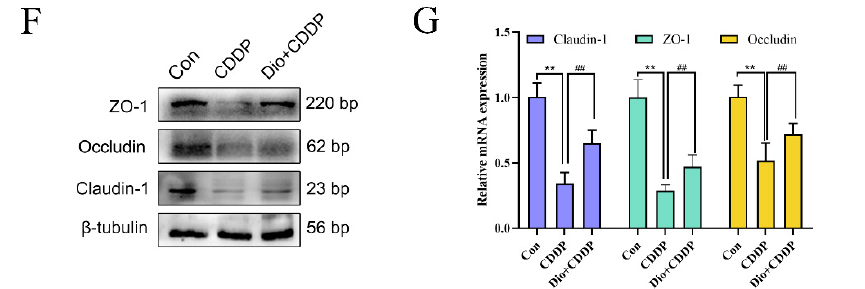
Figure 4. Dio protects the intestinal physical barrier by inhibiting CDDP-induced loss of E-cadherin and TJs proteins expression. ( A ) Bacterial culture results of MLNS. ( B )Bacterial translocation was analyzed by counting the number of colonies on the plate. ( C – E ) Changes in the relative protein expression levels of ZO-1, Occludin and Claudin-1 were measured respectively. ( F ) Representative Western blotting images of E-cadherin and TJs proteins, and the relative protein expressions were normalized to β -tubulin. ( G ) Relative mRNA expression of Claudin-1, ZO-1 and Occludin (n = 6 samples per group). ** p < 0.01 vs. control group, ## p < 0.01 vs. CDDP group.